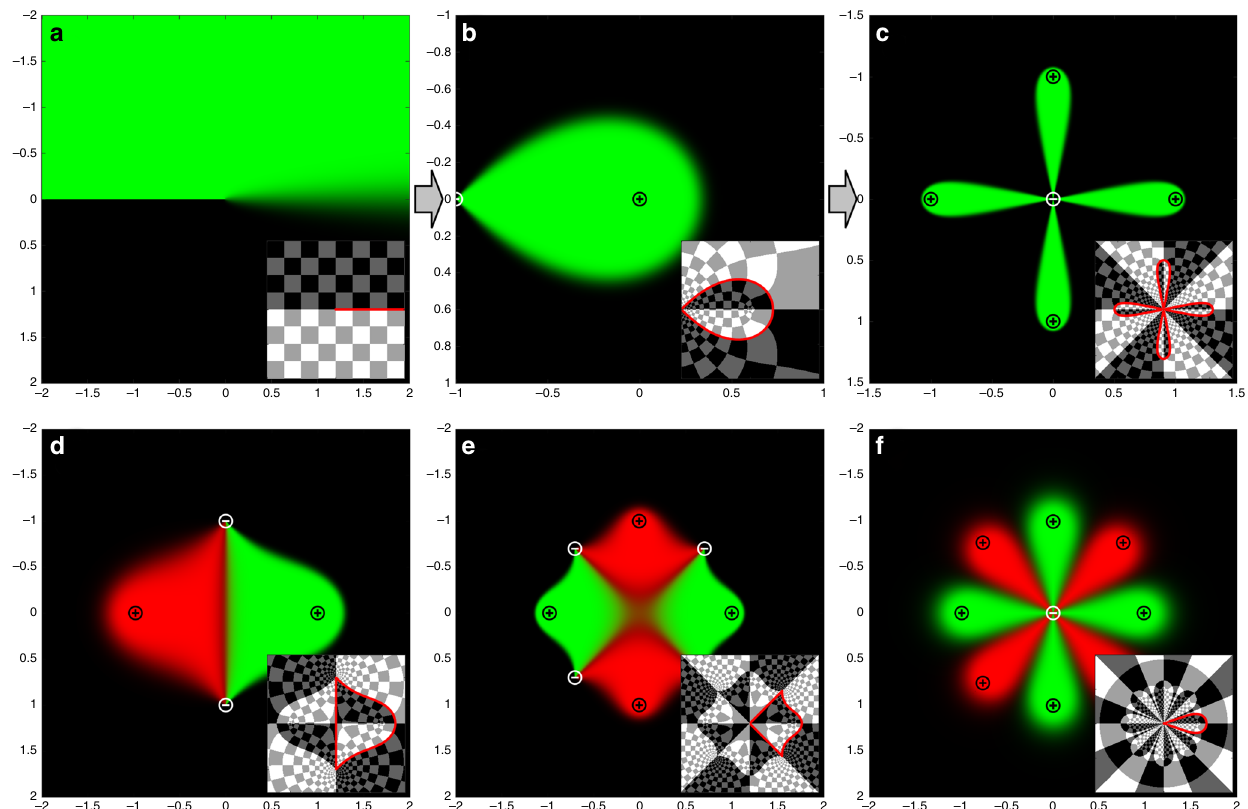
Fig. 2 Theoretical model. Solutions for a leading edge in a no-slip plane fl ow (Pe = 100) is fi rst obtained ( a ) and then transformed via the complex potential to obtain the dipole concentration pro fi le ( b ). This solution can then be further transformed to obtain symmetrical con fi gurations such as the “ fl ower multipole ” ( c ). Similar steps can be taken to obtain solutions for a variety of problems. Pictured here are ( d ) the micro fl uidic quadrupole ( e ) the “ poppy ” alternating multipole and ( f ) a multicolor “ fl ower multipole ” with different injected reagents. Black and white maps in inset represent the mapping of the upper complex plane and lower complex plane of solution ( a ), respectively. Checkerboard insets demonstrate how the transform used affects a regular grid. The red line corresponds to the line of concentration 1/2 and separates the “ interior ” and “ exterior ”